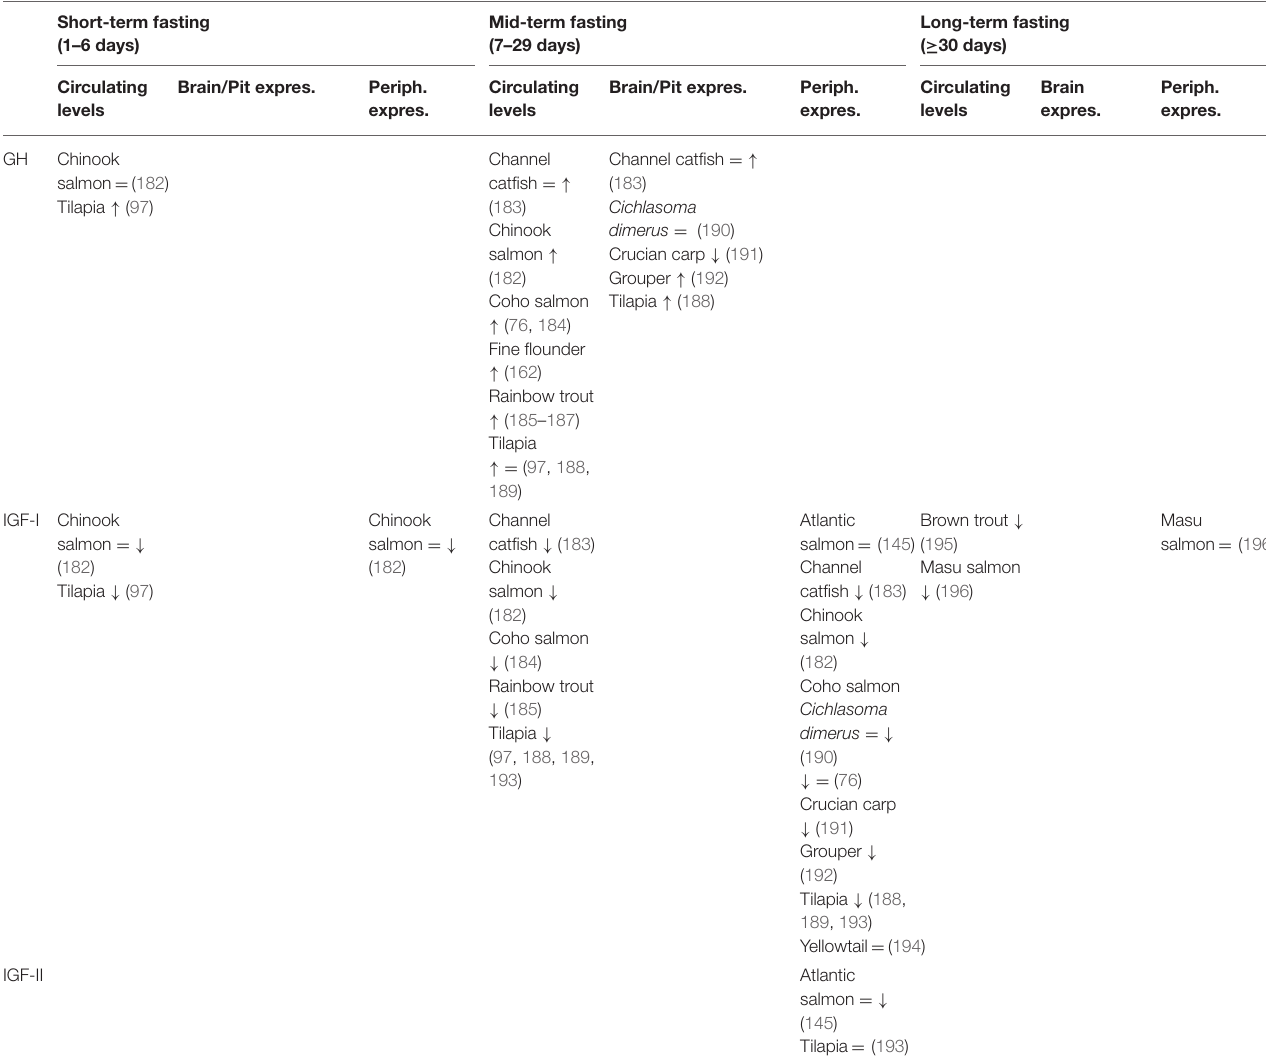
TABLE 3 | Effects of fasting periods of different duration on the circulating levels and the mRNA expression of the GH-IGF system endocrine components in several fish species. Short-term fasting (1–6